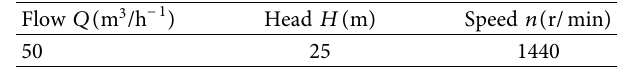
Table 1: Main design